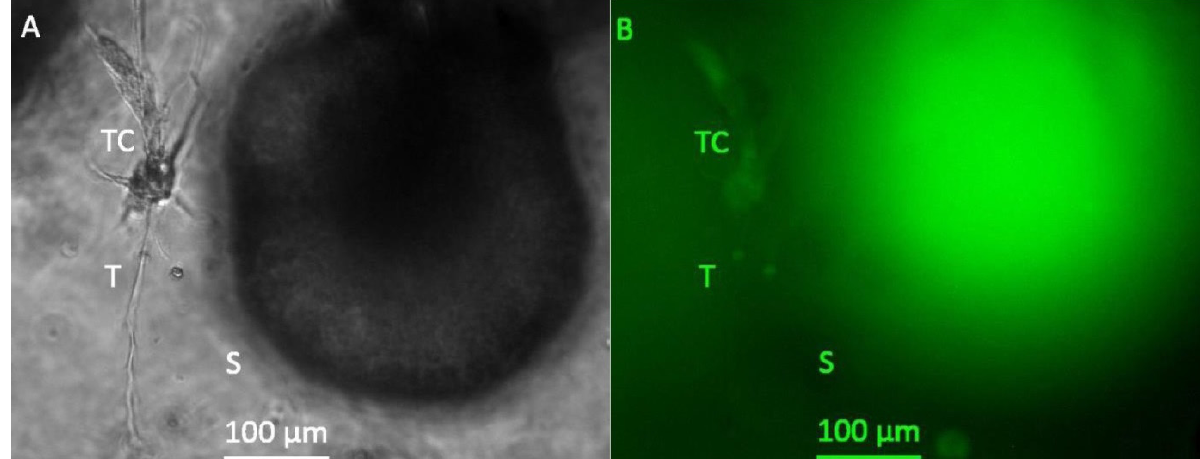
Figure 3. Representative photomicrographs of a 3D hydrogel tumor-stroma culture on day 20 ( A ): A tubular extension (T) with cell attachments at the origin (TC) is located in direct vicinity to a very large spheroid (s) ( B ): GFP fluorescent picture of ( A ). The spheroid is completely GFP-positive, the cell attachments (TC) at the tubular structure are also slightly GFP-positive. The fine tubular extension (T) is GFP-negative.